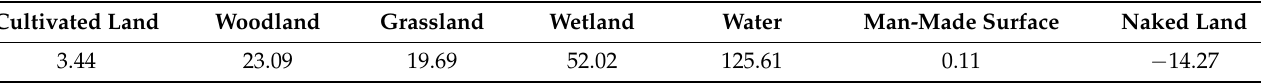
Table 2. Fujian Province ecological service value equivalent factor